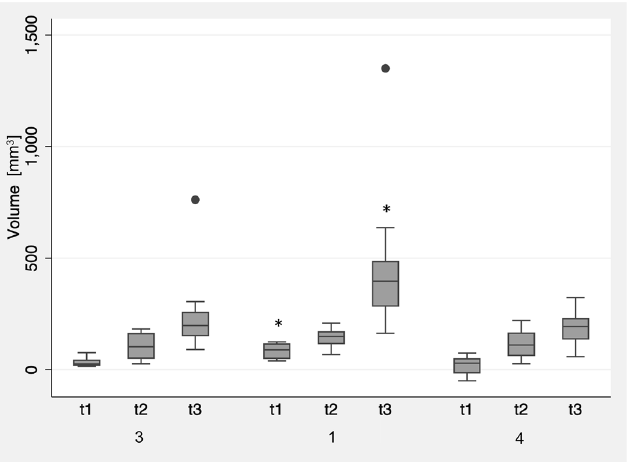
Figure 8. Influence of the number of horizontal and vertical shells on the dimensional changes of group At after 3D printing (t1), annealing (t2), and steam sterilization (t3) compared to the original STL file. Asterisks (*) indicate significance to standard printing parameters with 3 shells at the respective time point.